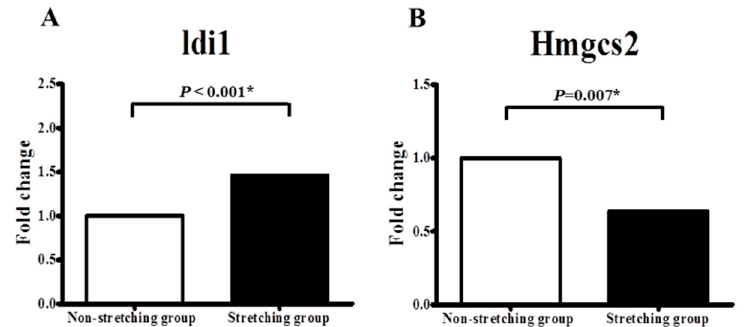
Figure 4. Quantitative determination of mRNAs of ( A ) isopentenyl-diphosphate delta isomerase ( Idi1 ) and ( B ) 3-hydroxy-3-methylglutaryl coenzyme A synthase 2 ( Hmgcs2 ), by real-time RT-PCR in non-stretched and stretched HL-1 atrial myocytes. * p < 0.05.